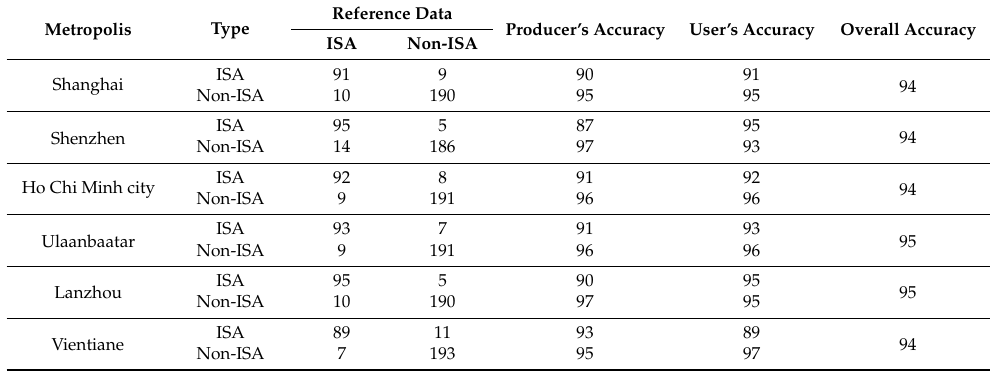
Table 3. Accuracy assessment results of impervious surface area (ISA) mapping of the six selected metropoles in